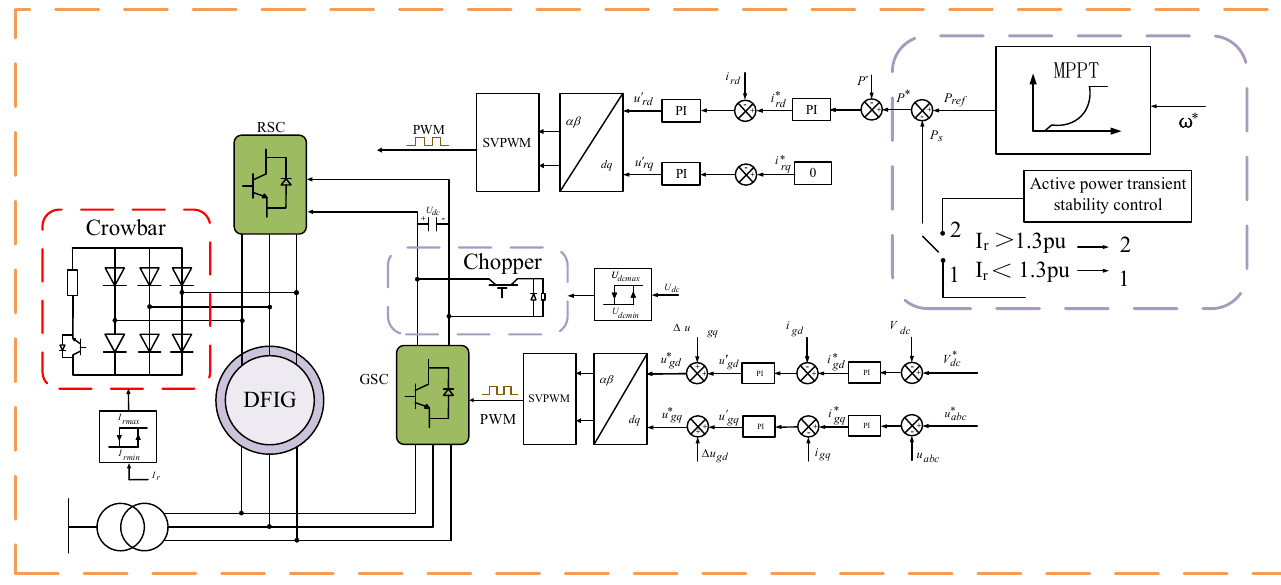
Figure 10. DFIG active ‐ power transient frequency characteristic control.